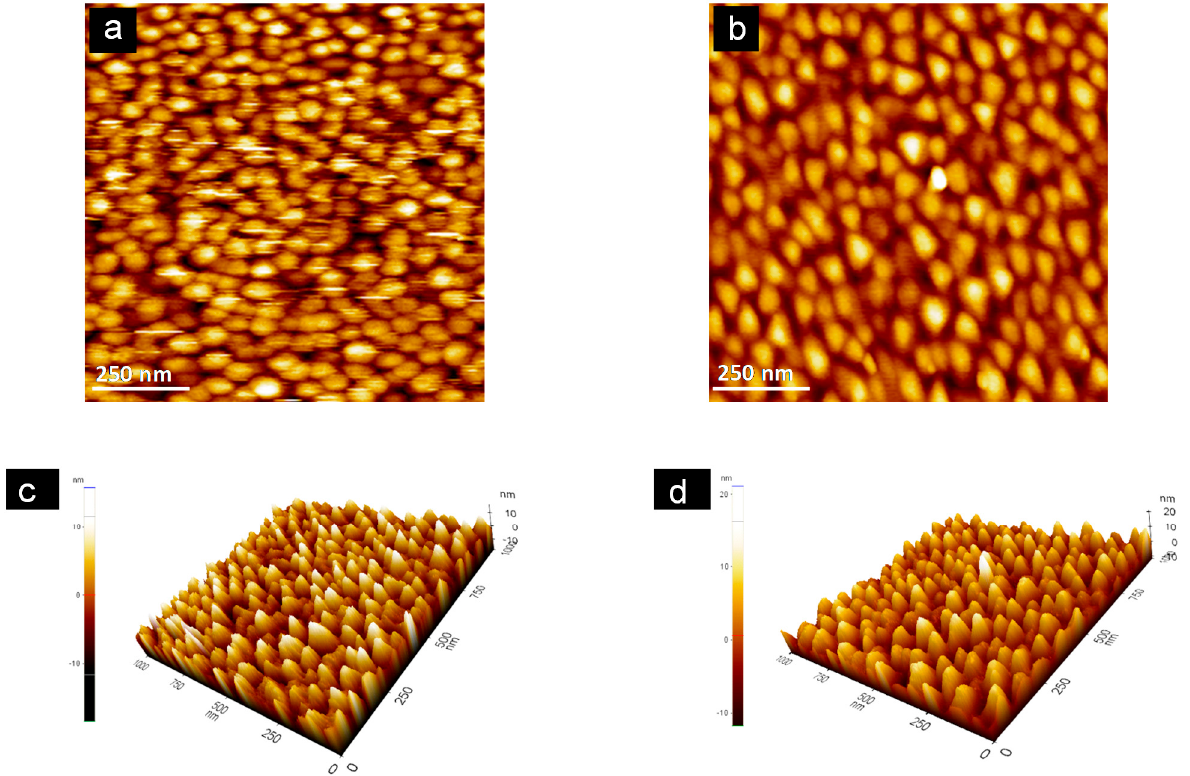
Figure 5. Non-contact mode AFM images (scan size 1 µ m × 1 µ m) of ( a ) gold sensor chip surface after being modified with Pty and coupled with ssDNA, and ( b ) gold sensor chip surface after being modified with MCH and coupled with ssDNA. The three-dimensional (3D) images of ( a , b ) are shown in the figures marked ( c , d ), respectively.